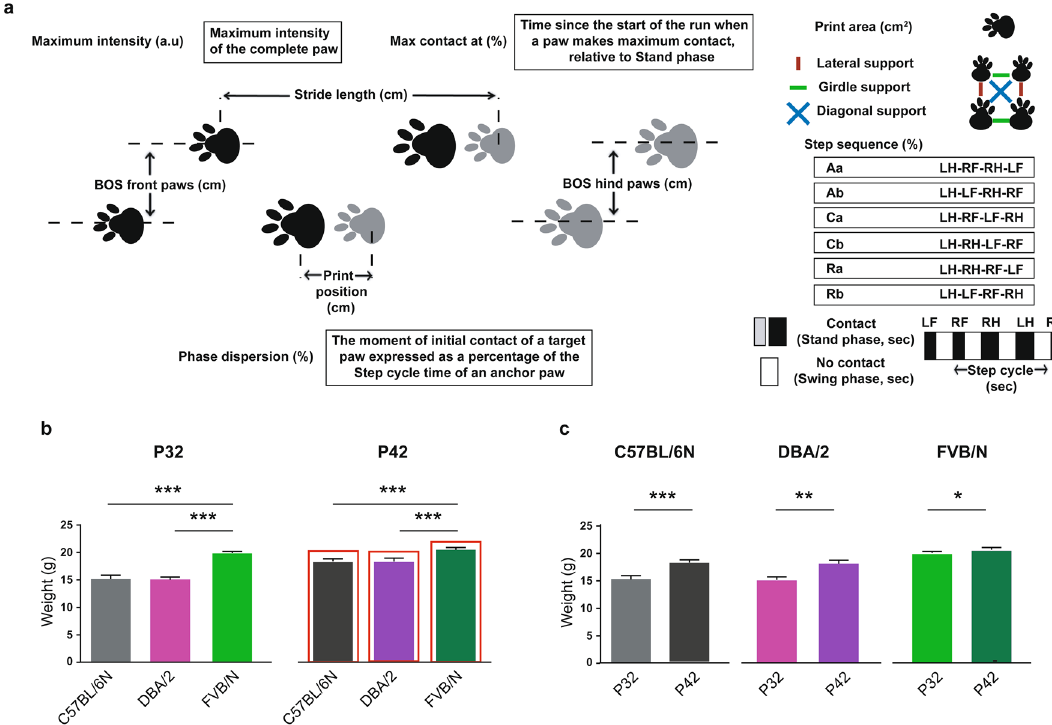
Figure 1. ( a ) Graphical representation of selected gait parameters. RF right front paw, LF left front paw, RH right hind paw, LH left hind paw. ( b ) FVB/N mice showed increased body weight compared to C57BL/6N and DBA/2 mice at P32 and P42. ( c ) Comparison of the body weights of mice at P32 and P42 within each strain. Two-way ANOVA followed by Tukey’s post hoc test for multiple comparisons to determine differences between the three strains and Bonferroni correction to check differences between males and females within each strain, * p ≤ 0.05, ** p ≤ 0.01, *** p ≤ 0.001. A red rectangle indicates a significant difference between sexes within a strain (see Supplementary Table S1). Error bars indicate the standard error of the mean include in our method any light stimulus, food enticement or even using the home cage as bait at the end of the walkway. On the following day, mice were tested by crossing the corridor three times. A compliant run is described as a mouse walking across the runway without stopping, turning around, or changing direction. We set up the minimum and maximum run durations to be 0.5 and 12 s, respectively. Three compliant runs made up the testing run. We have configurated different detection settings for the 3 strains. For all C57BL/6N and DBA/2 mice, the same detection settings were used (Camera Gain: 23.70, Green Intensity Threshold: 0.12, Red Ceiling Light: 17.7, and Green Walkway Light: 16.5). Due to their larger body size and weight, all FVB/N mice required other detection settings (Camera Gain: 16.99, Green Intensity Threshold: 0.10, Red Ceiling Light: 17.7, and Green Walkway Light: 16.5). For the analysis, gait parameters were automatically generated after each foot- print being manually checked and respectively labeled LF (Left Front), LH (Left Hind), RF (Right Front), and RH (Right Hind) paws. For the presentation of the data, we categorized the gait parameters into 4 major groups: (a) run characteristics and kinetic parameters, (b) temporal parameters, (c) spatial parameters, (d) interlimb coordination parameters. These parameters include body and swing speeds, stand and swing times, step cycle, maximum contact at (% of stand time), print area, maximum intensity, base of support, stride length, print posi- tion, support, phase dispersion, and step sequences (for more details about the tested parameters, see Fig. 1a). Statistical analysis. For the comparison of the body weights of mice in Fig. 1b, two-way ANOVA was used with sex and genotype as the two factors. This was followed by Tukey’s post hoc test for multiple comparisons to determine differences between the three strains C57BL/6N, DBA/2, and FVB/N and Bonferroni correction to check differences between males and females within each strain. For the gait parameters, three compliant runs of each mouse made up the testing run. Two-way ANOVA followed by Bonferroni correction was used to compare the average values of the three runs for each C57BL/6N and DBA/2 mouse, with sex and genotype as the two fac- tors. To compare the gait parameters at the two developmental stages, P32 and P42, within each strain, two-way ANOVA was used with sex and age as the two factors. All data were expressed as mean ± SEM. For measuring the correlation between average speed, body weight and different gait parameters, Pearson’s correlation coeffi- cient was used separately for each strain by combining the data of the two investigated developmental stages. A p value ≤ 0.05 was considered statistically significant. Statistical analysis was performed using GraphPad Prism 7 and Microsoft Office Excel software. The respective numbers of male and female mice per cohort are described in Table 1.